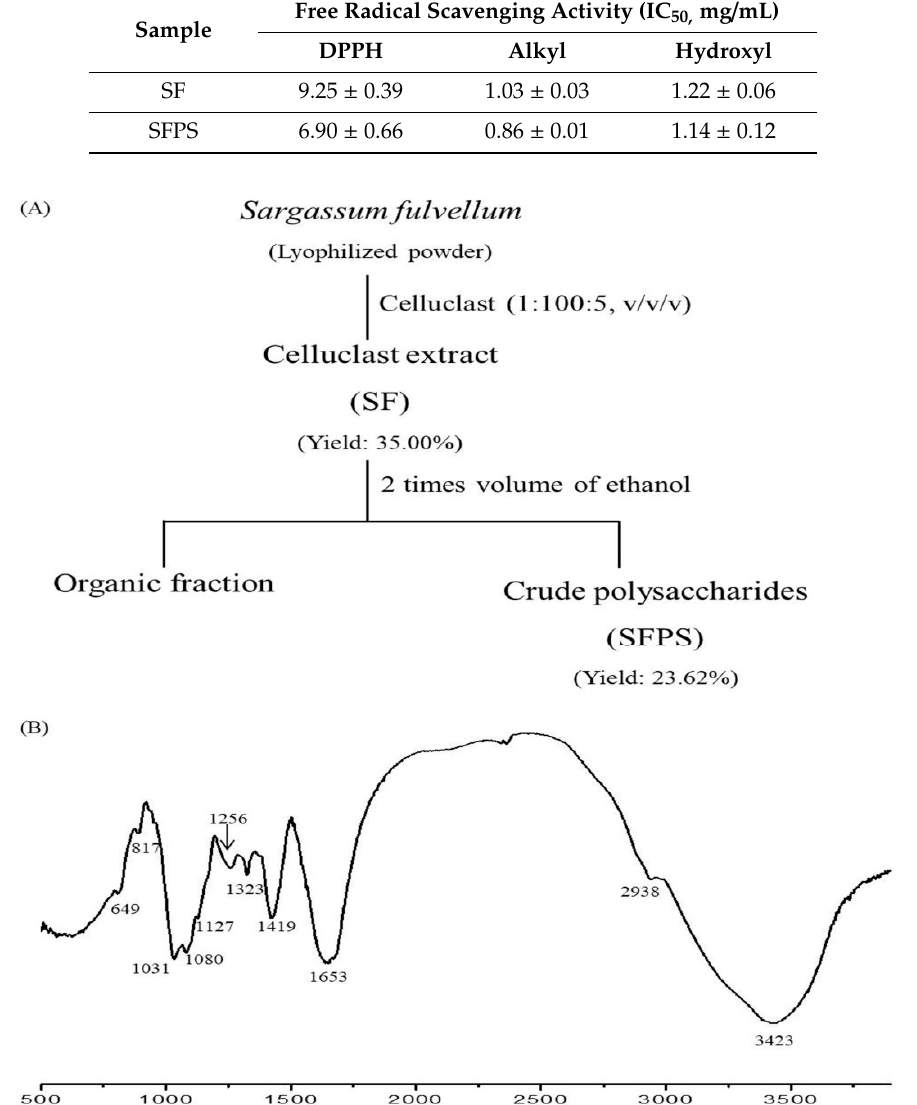
Table 2. Free radical scavenging activities of SF and SFPS obtained from S. fulvellum.